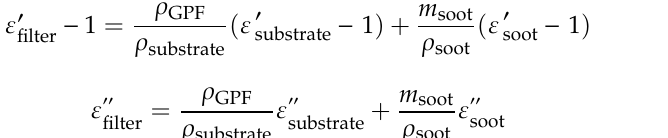
Figure 3. Measured dielectric parameters of PrintexU (left: ε soot (cid:4593) ; right: ε soot (cid:4593)(cid:4593) ) from 20 °C to 600 °C. The mean dielectric properties of the soot-loaded filter are then found using Equation (19) (where (cid:48) − (cid:48) the degree of polarization χ e = ε 1 is considered instead of ε ) and Equation (20). The proportions of both components result from the density present in the filter relative to the bulk density. The latter was determined using a helium pycnometer Micromeritics AccuPyc 1330 (Micromeritics Instrument Corp., Norcross, GA, USA). For cordierite (obtained from a crushed GPF), the density was ρ substrate = 2500 kg / m 3 , and for PrintexU, the density was ρ soot = 1060 kg / m 3 . The density of the filter ρ GPF was calculated using the mass and volume of the